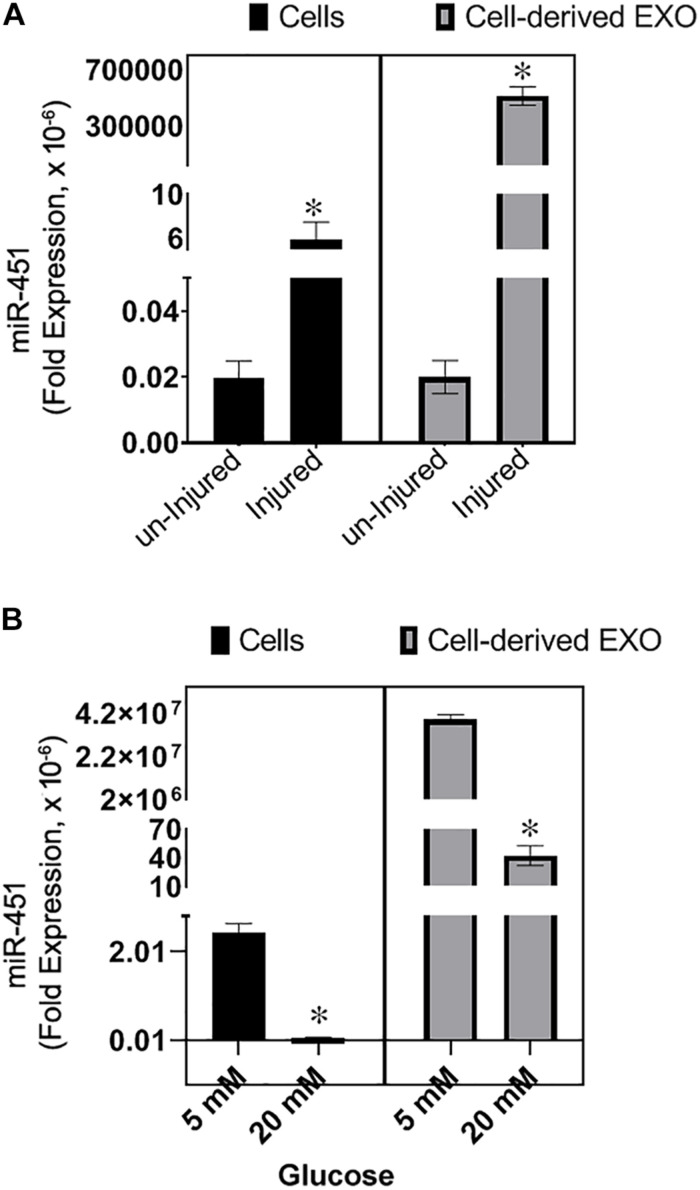
Effect of injury and high glucose on miR-451 expression in primary human proximal tubule (hPT) cells and hPT-derived exosomes. Bar graphs show fold expression of miR-451 in the hPT cells and hPT-derived exosomes in the media. (A) The hPT cells were injured by scratching with a 10-μl tip or remained uninjured. Total RNA was extracted after 24 h of injury. (B) hPT cells were cultured in the medium containing 5 or 20 mM glucose for 48 h. Fold expression of miR-451 gene was normalized against 18S ribosomal RNA using the formulae 2–ΔCT. Experiments were repeated three times. The data are represented as mean ± SEM. *p < 0.05 was considered significant by unpaired t-test.